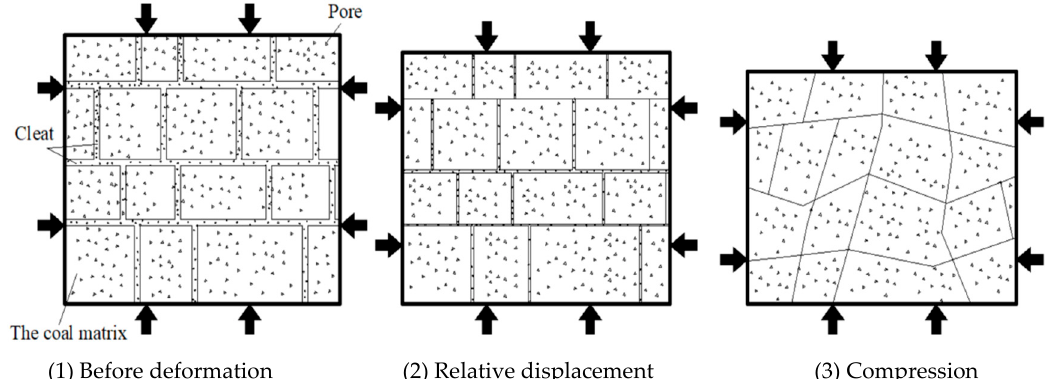
Figure 1. Structural deformation.